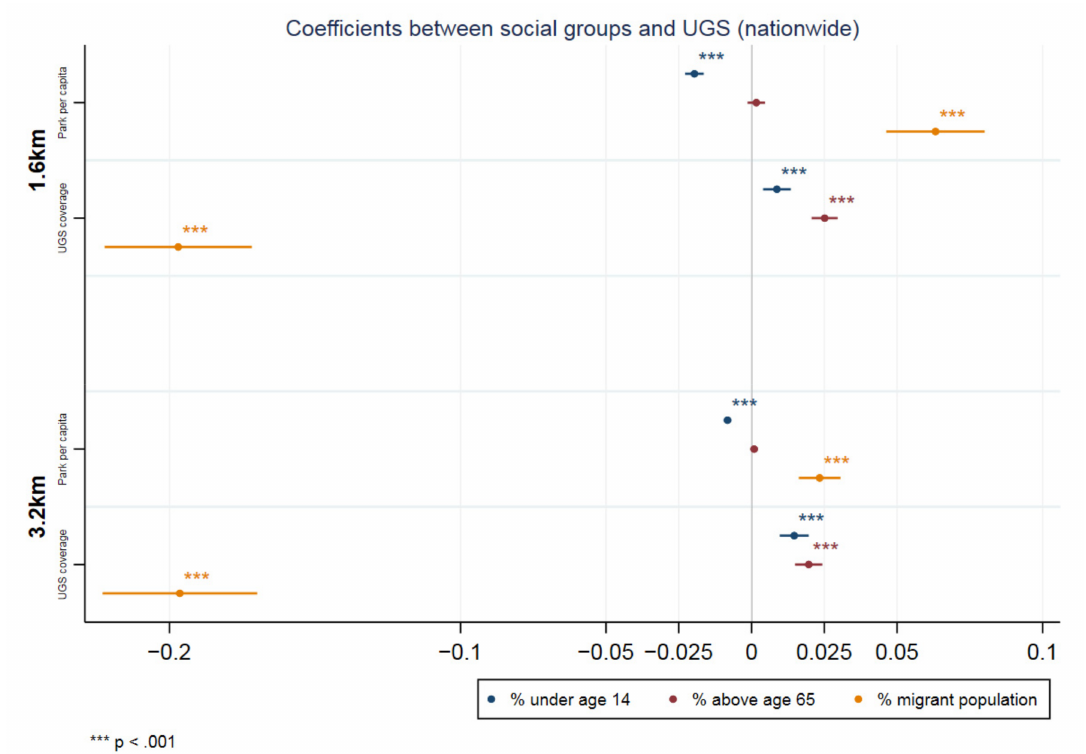
Figure 5. Nationwide coe ffi cients between di ff erent social groups and urban green space